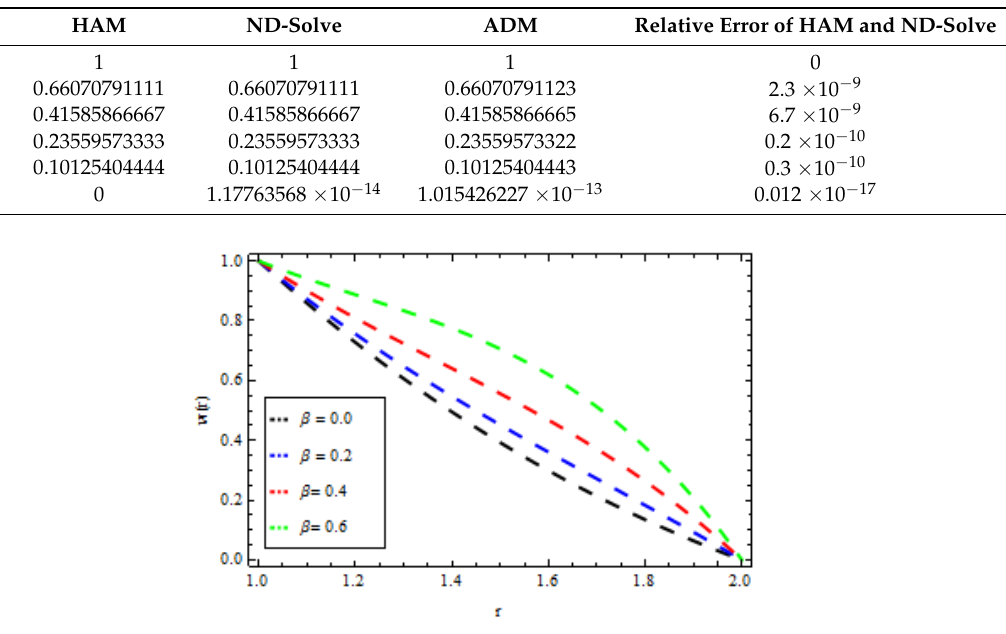
Table 3. Numerical comparison of HAM, ND-Sole Methods and Adomian decomposition method (ADM) for β = 0.2, δ = 2, K = 0.1, M = 0.2.